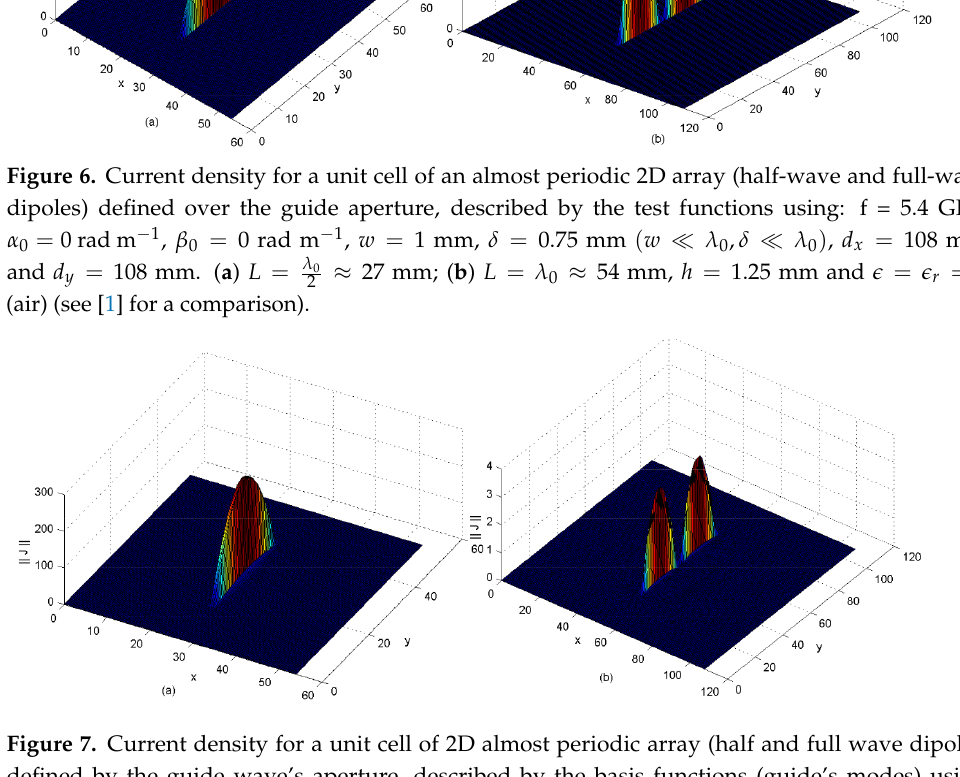
Figure 7. Current density for a unit cell of 2D almost periodic array (half and full wave dipoles) defined by the guide wave’s aperture, described by the basis functions (guide’s modes) using: f = 5.4 GHz, α 0 = 0 rad m − 1 , β 0 = 0 rad m − 1 , w =1 mm, δ = 0.75 mm ( w (cid:28) λ 0 , δ (cid:28) λ 0 ) , ≈ 27 mm; ( b ) L = λ ≈ 54 mm, h = 1.25 mm and (cid:101) = (cid:101) r = 1 d x = 108 mm, d y = 108 mm. ( a ) L = λ 0 0 2 (air) (see [1] for a